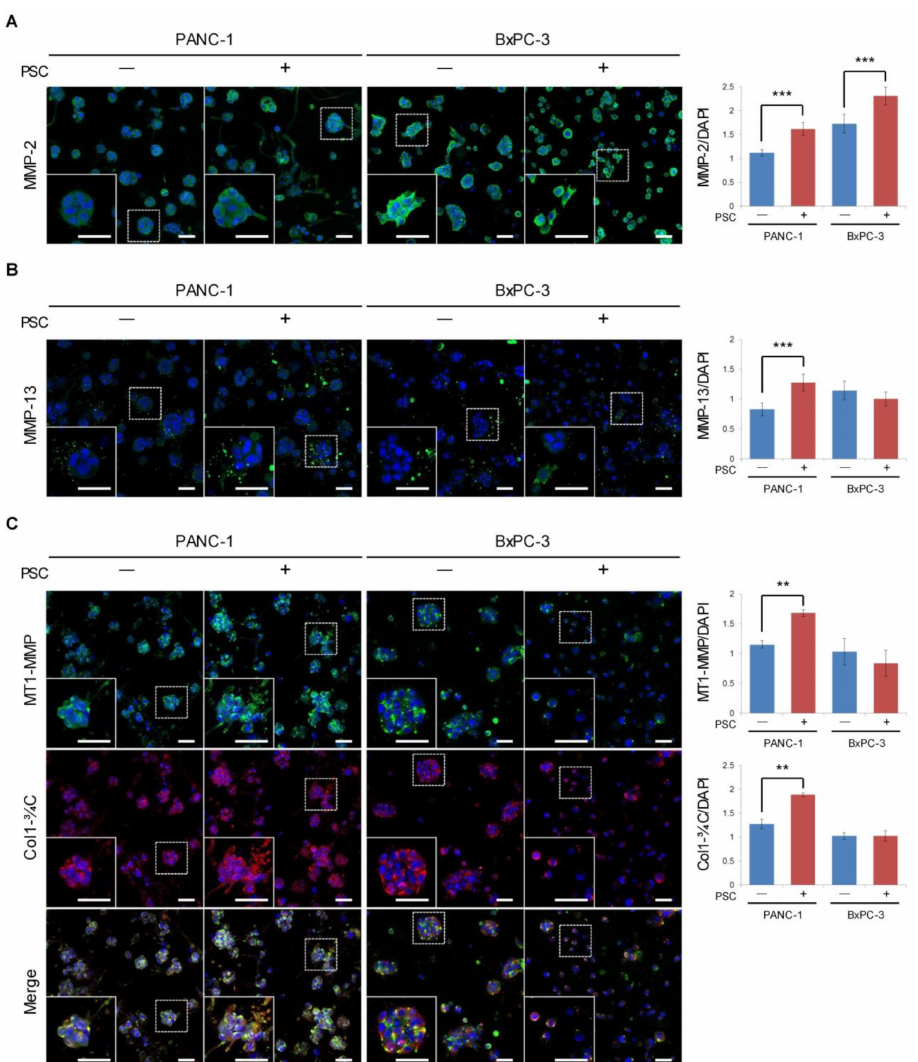
Figure 6. Di ff erential expression levels of matrix metalloproteinases (MMPs) and cleaved collagen in tumor spheroids (TSs) of PANC-1 and BxPC-3 cells. The expression levels of MMP-2 ( A ), MMP-13 ( B ), MT1-MMP, and Col1- 3 C ( C ) were normalized by nuclear staining with DAPI. Optical sections were 4 acquired at 6 µ m (10 × ) or 2 µ m (40 × ) intervals and stacked into a z-projection. Three fields covering 80% of the e ff ective area in each channel were imaged per experiment and subjected to analysis. Data were obtained from three separate independent experiments. Scale bar: 50 µ m ( A – C ). ** p < 0.01, *** p <